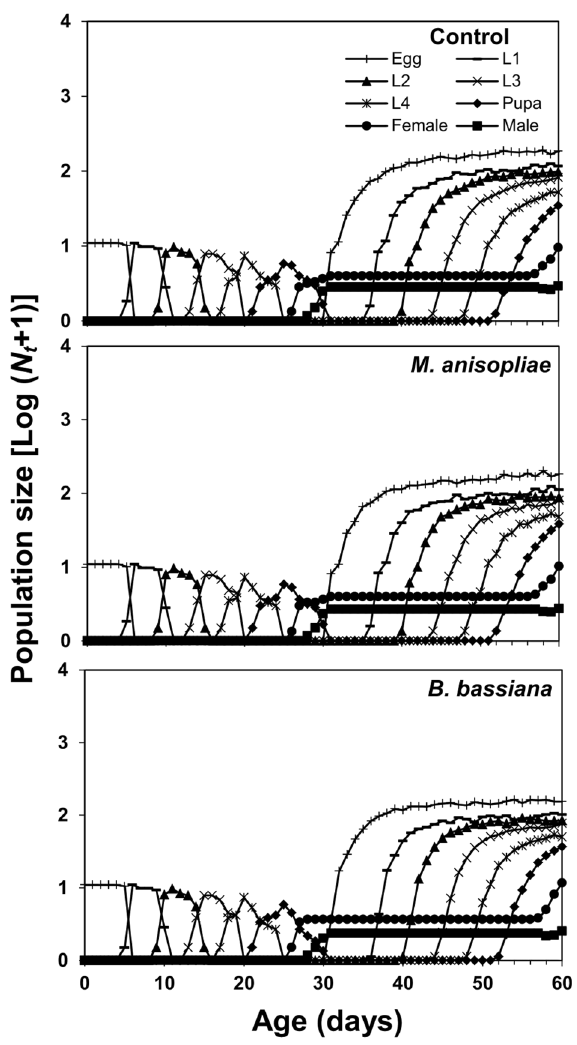
Figure 5. Population projection showing the change of stage-structure of Coccinella septempunctata after exposure of entomopathogenic